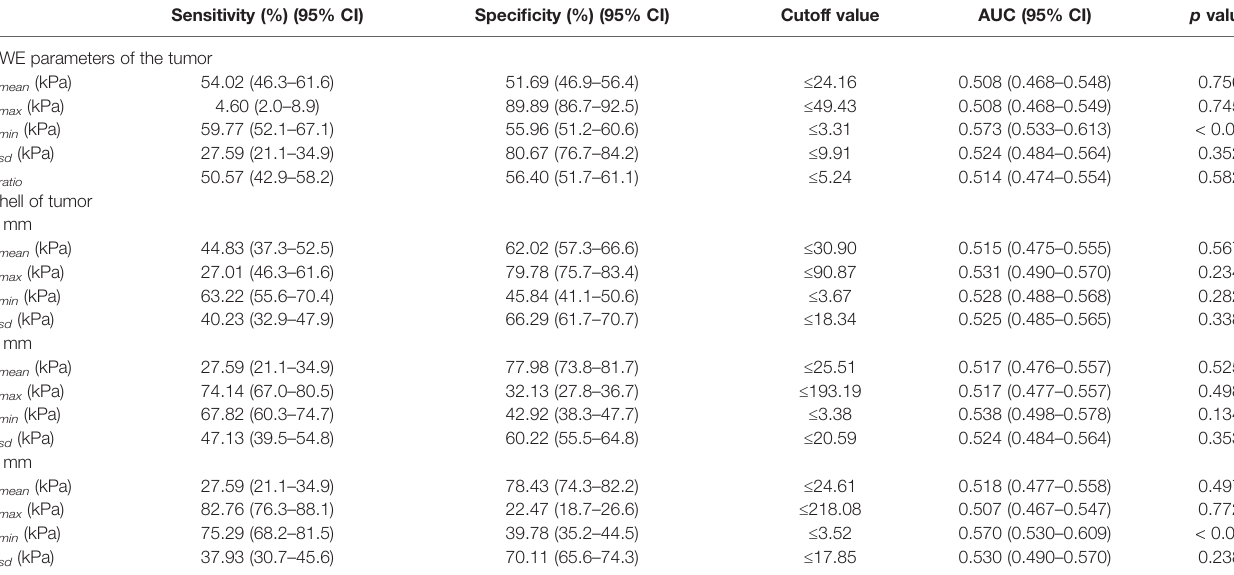
TABLE 4 | Quantitative SWE evaluation of the tumor and peritumor shell for the predicting of axillary LN